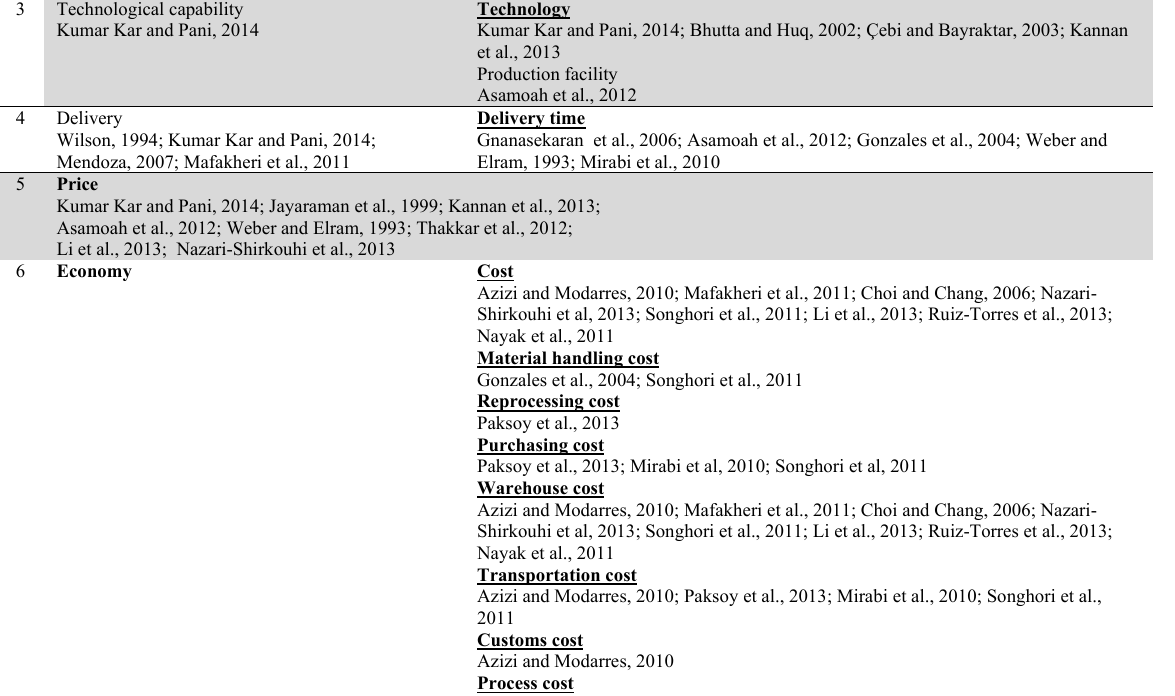
Criteria and sub criteria used in the previous researches on supplier selection (Continued) Criteria Sub criteria